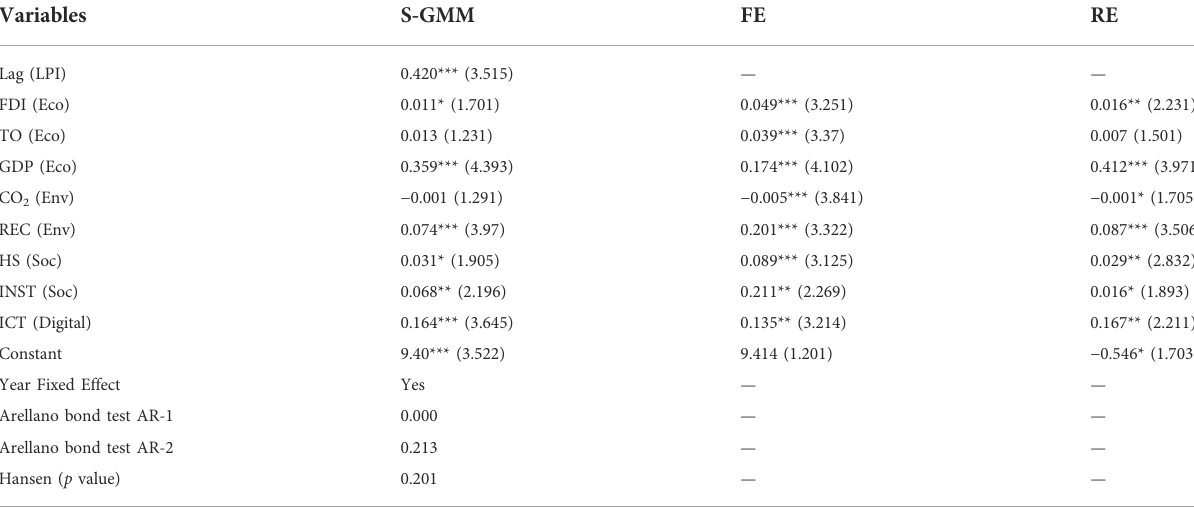
TABLE 4 Empirical results of panel SSA from S-GMM, FE and RE